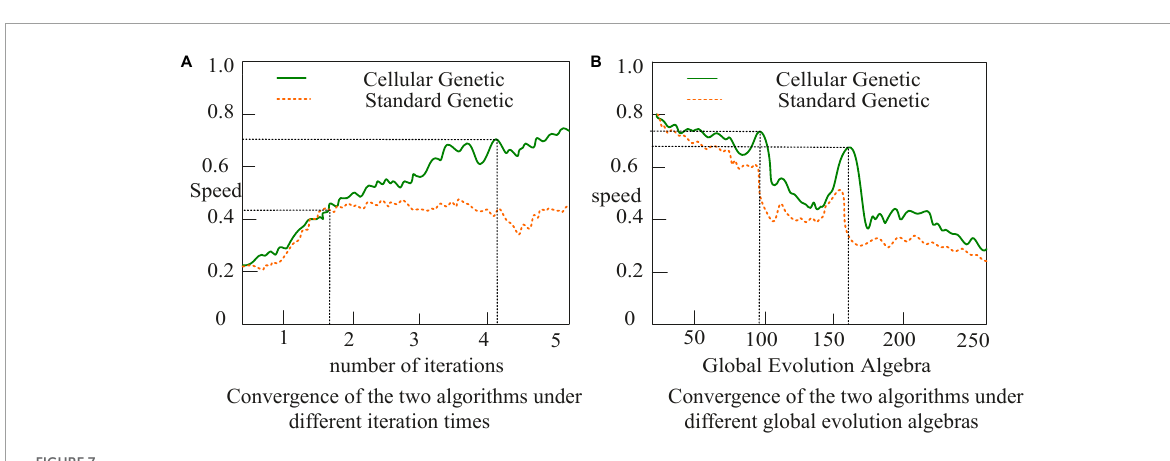
FIGURE7 Changes in the convergence of standard genetic algorithm and cellular genetic algorithm. (A) Convergence of the two algorithms under different iteration times. (B) Convergence of the two algorithms under different global evolution algebras.